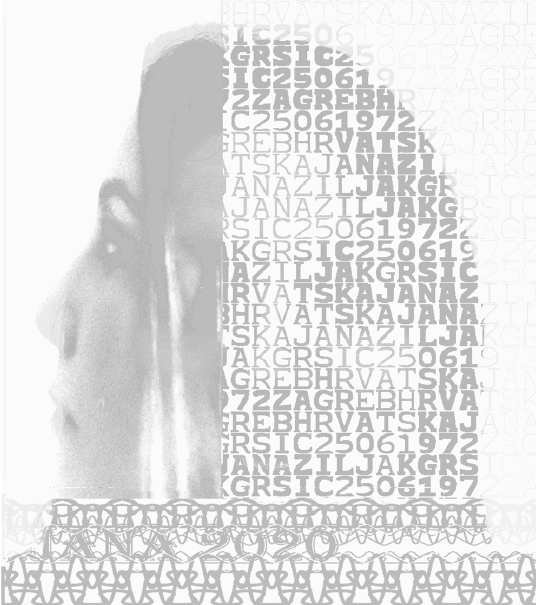
Figure 13. Black channel (K).